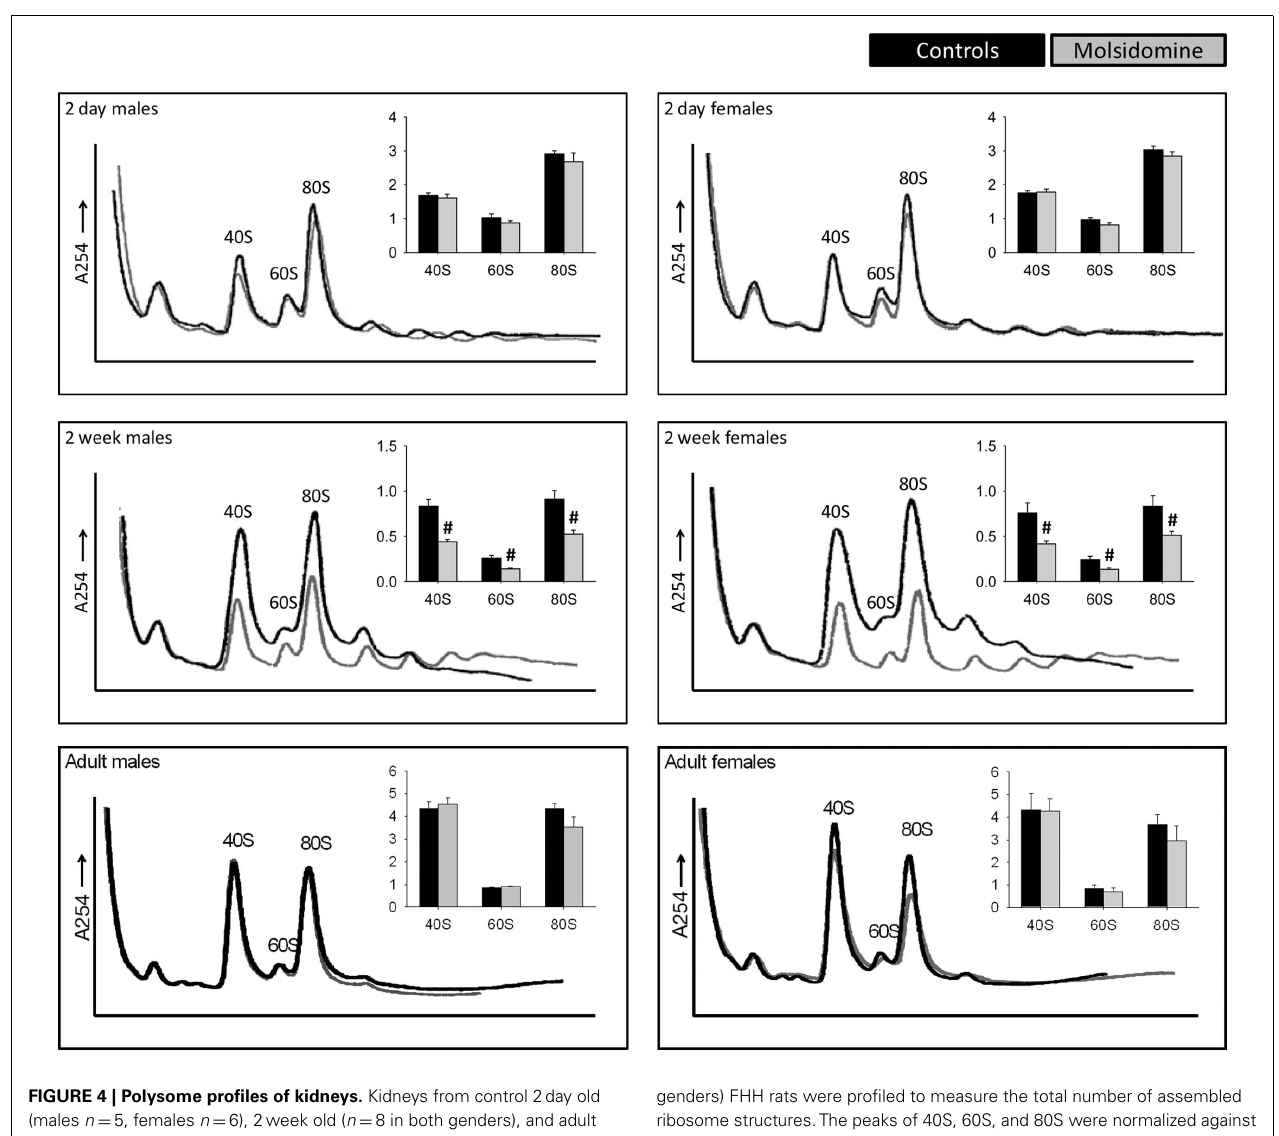
FIGURE 4 | Polysome profiles of kidneys. Kidneys from control 2day old (males n = 5, females n = 6), 2week old ( n = 8 in both genders), and adult ( n = 4 in both genders) and molsidomine-treated 2day old (males n = 4, females n = 6), 2week old ( n = 9 in both genders) and adult ( n = 5 in both